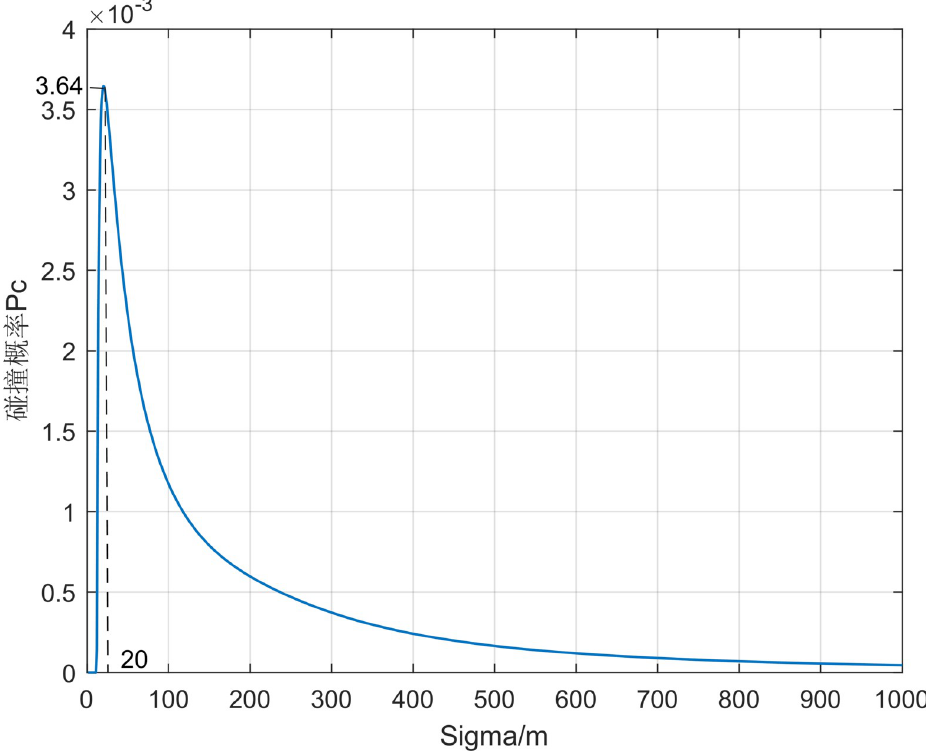
Fig 11. P c values with σ x changing when σ x : σ y : σ z =